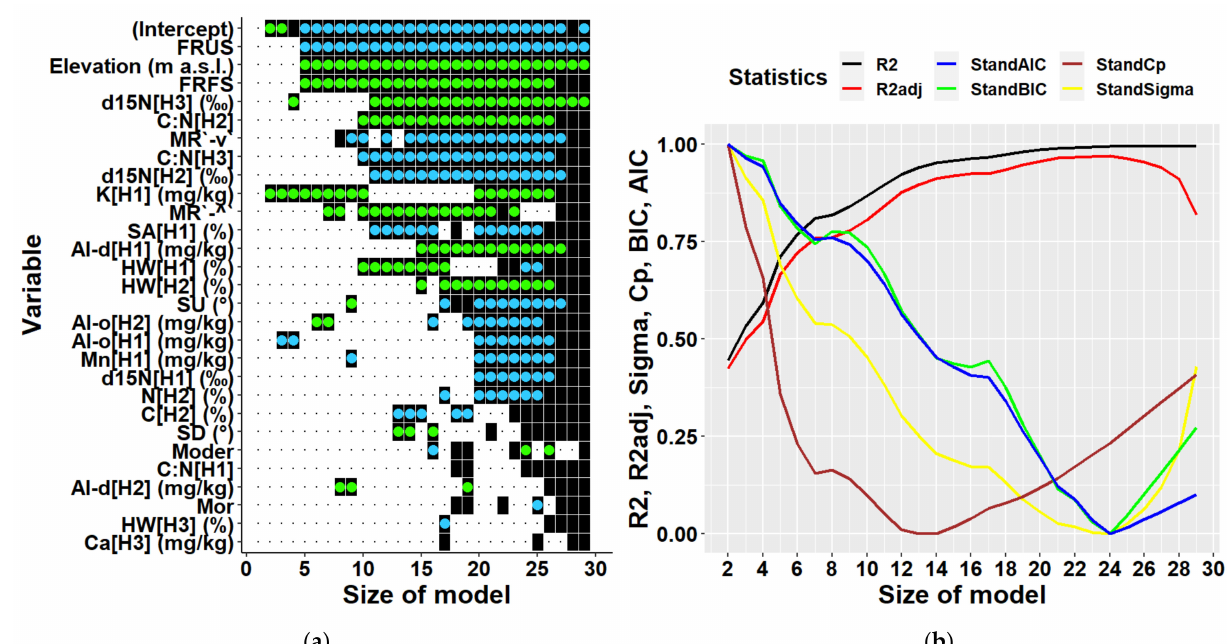
Figure 7. Predictors ( a ) and statistical characteristics ( b ) of multiple regression models of tree biomass derived for both locations together. Size of model represents the number of predictors included in the multiple regression model. Participation of individual variables in multiple regression models of biomass is indicated in the left figure by black squares, while black dots indicate their absence. Green dots inside black squares indicate significant positive impacts of respective variables, while blue dots represent their significant negative impacts. Predictors are identified by a combination of variable abbreviations, soil layers, and units if applicable as follows: Variables: Al-d—content of dithionite-extractable aluminium in (mg/kg), Al-o—content of oxalate-extractable aluminium in (mg/kg), C—carbon content in (%), C:N—C:N ratio, Ca—calcium content in (mg/kg), d15N—ratio of stable nitrogen isotopes 15N:14N in (‰), Elevation—elevation in (m a.s.l.), FRFS—form of relief—foot of slope, FRUS—form of relief—peak, upper slope, HW—hygroscopic water in (%), K—potassium content in (mg/kg), Mn—manganese content in (mg/kg), Moder—humus form, Mor—humus form, MR‘-ˆ‘—micro relief (flat terrain along the contour line and concave terrain along the slope), MR‘-v‘—micro relief (flat terrain along the contour line and convex terrain along the slope), N—nitrogen content in (%), SA—sand fraction in (%), SD—slope downward in ( ◦ ), SU—slope upward ( ◦ ); soil layers presented in square brackets: H1—layer at 0–10 cm soil depth, H2—10–20 cm depth, H3—20–30 cm depth; statistical characteristics of derived models presented in figure ( b ) are as follows: R 2 —R-squared, R 2 adj—adjusted R-squared, AIC—AKAIKE information criterion, BIC—BAYESIAN information criterion, Cp—Mallows’ statistic, Sigma—residual standard